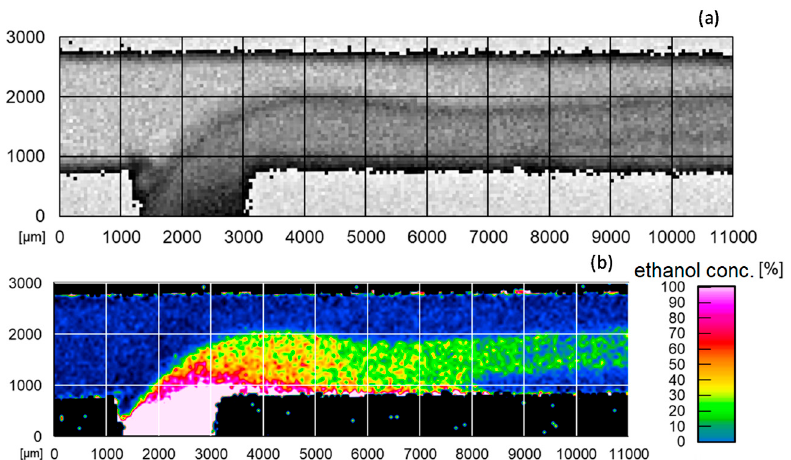
Figure 10. ( a ) 11 × 3 mm Raman scan of ethanol in the reactor and ( b ) 11 × 3 mm false-color image of the ethanol concentration curve in the reactor calculated from quotient method